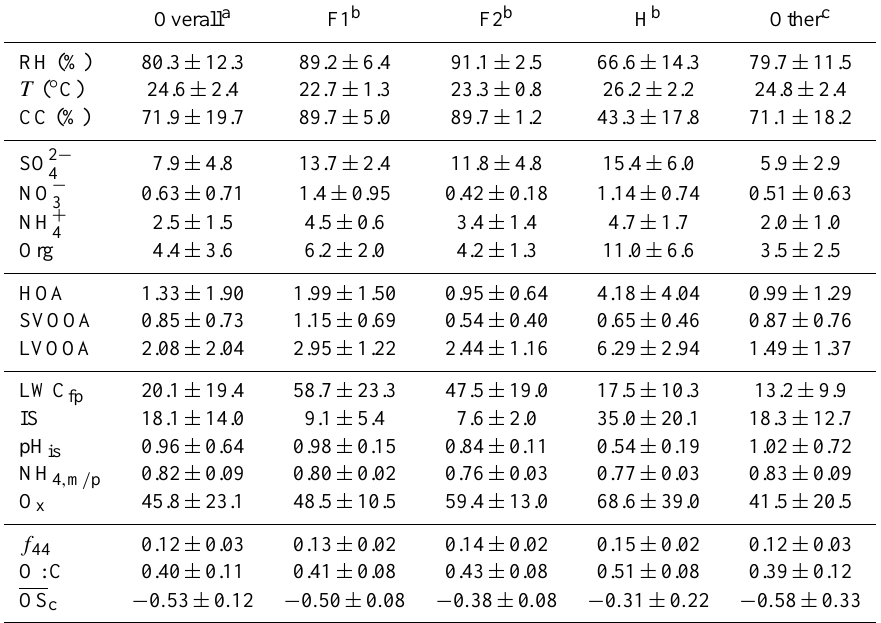
Table 1. Measured and calculated parameters in three chosen periods (F1, F2, and H), and those in the overall and the non-foggy/non-hazy (“other”)